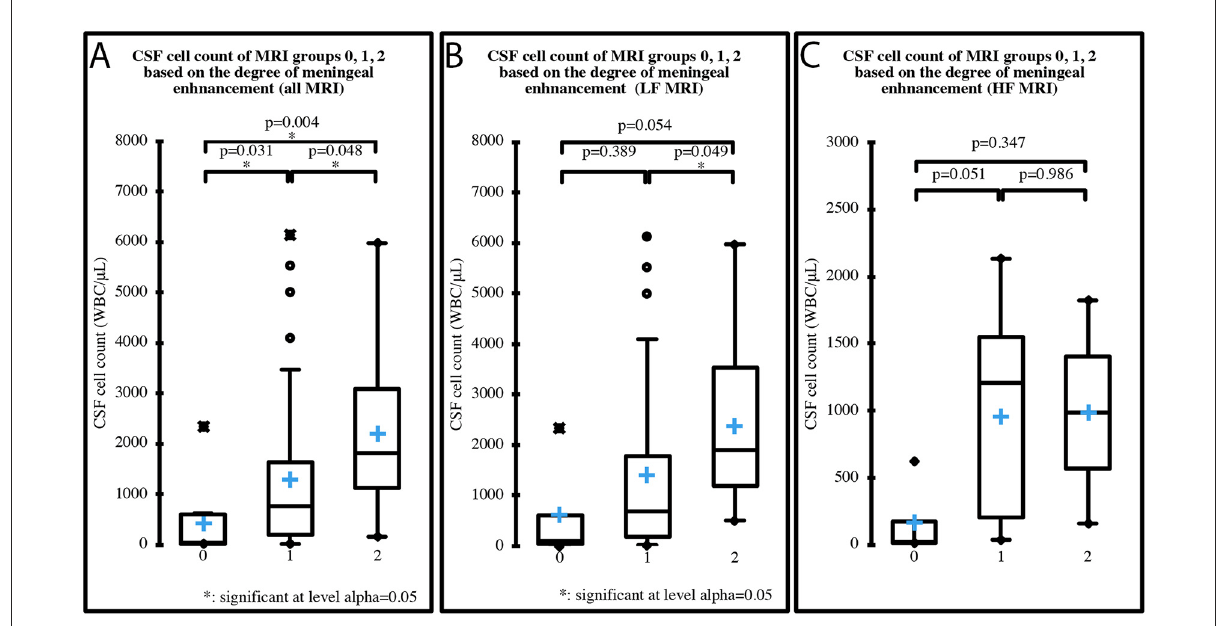
FIGURE4 CSF cell count distribution in MRI groups based on the degree of meningeal enhancement (group 0 = absent, group 1 = mild, group 2 = marked), analyzing all 70 MRI (A) , the 50 LF MRI (B) and the 20 HF MRI (C) . Boxes contain values from 1st to 3rd quartile, lines inside boxes indicate median values, crosses inside boxes indicate mean values, endpoints of vertical lines are proportional to the interquartile-deviation and dots outside “whiskers” represents outlier